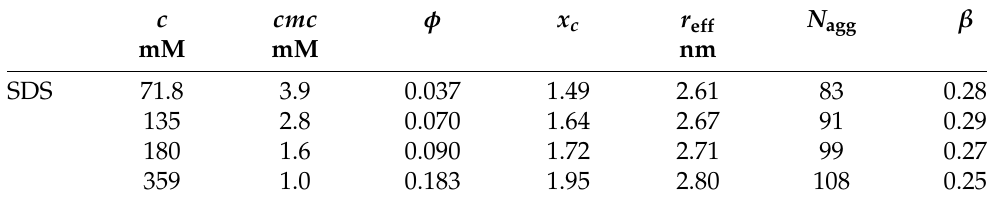
Table 2. Parameters extracted from SANS model fits (core-shell ellipsoid form factor + RMSA structure factor) of pure anionic SDS in D 2 O at 20.0°C. The volume fraction φ and the effective radius r eff refer to micelles, including their hydration